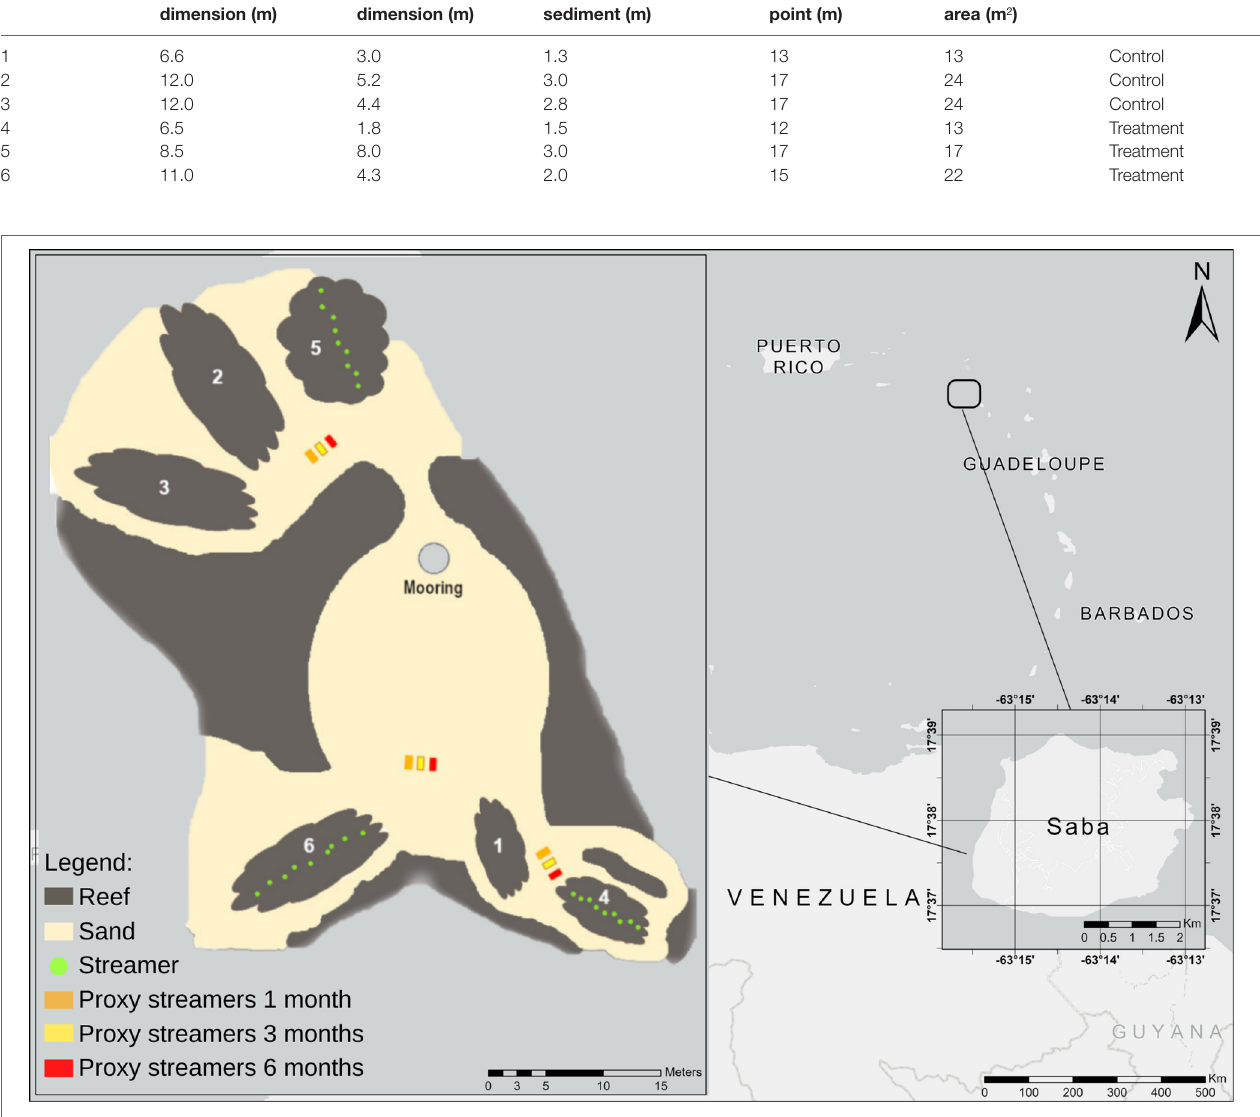
Depth deepest point